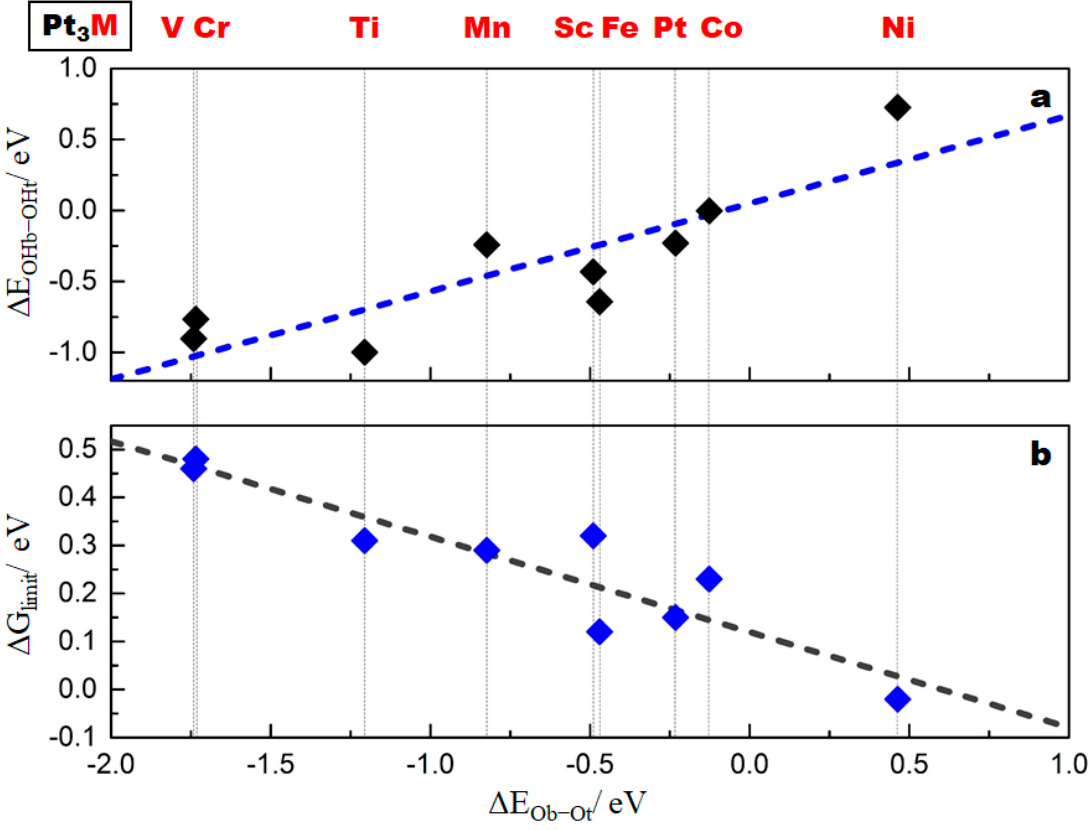
Figure 5. The correlations of ( a ) the adsorption energy difference between OH* species adsorbed on the interfacial and top sites ( Δ E OHb-OHt ), and ( b ) the free energy change for the rate limiting step ( Δ G limit ) of ORR to the oxygen adsorption energy difference of both sites ( Δ E Ob-Ot ).